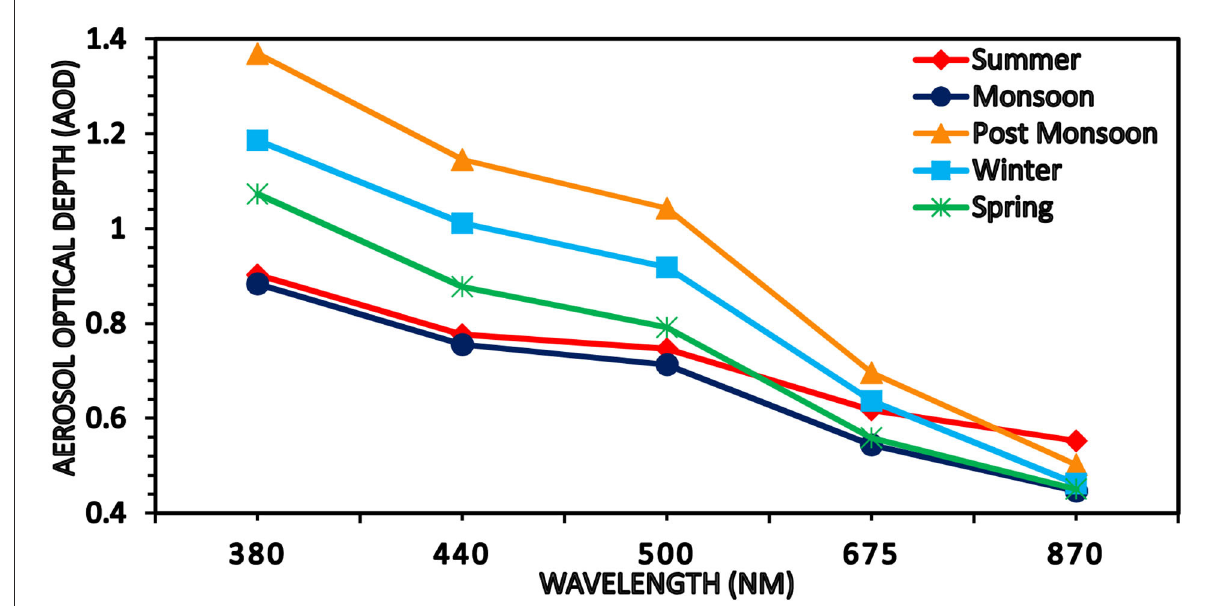
FIGURE7 Seasonal variation in AOD over Varanasi using MICROTOPS-II Sunphotometer during April 2019–March 2020.